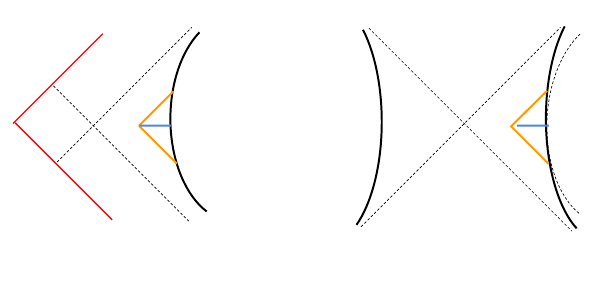
Figure 3. The left panel is the original black hole geometry, with a bulk region de(cid:12)ned either by sending two light rays from the boundary (the orange lines) or by (cid:12)xing the proper distance from the boundary (the blue line). The right panel is the two replica wormhole geometry, which has a temperature lower than the original black hole temperature. The dashed curve is the original boundary and the solid curve is that in the two replica geometry. Using the same light rays will thus de(cid:12)ne a bulk region that is larger than the region de(cid:12)ned by (cid:12)xing proper